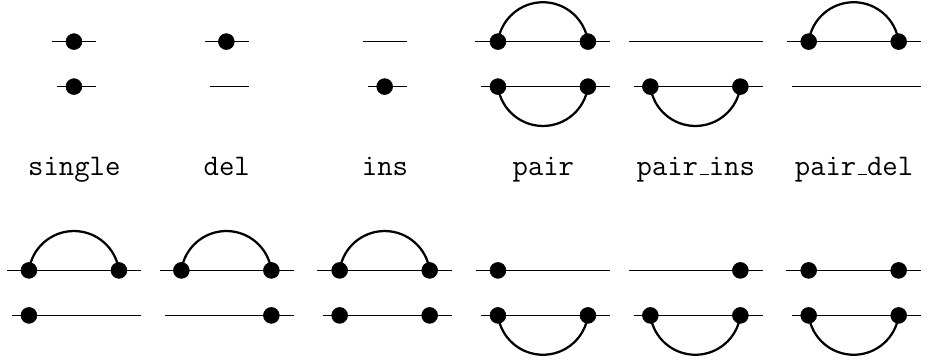
Figure 5. Operators for edit operations in the core signature. Deletion of a base pair may remove both bases ( pair del ) or solely the 5’ or 3’ partner leaving the remaining partner as a bulge ( pairL del and pairR del ). Symmetrically, we have all operators for insertion